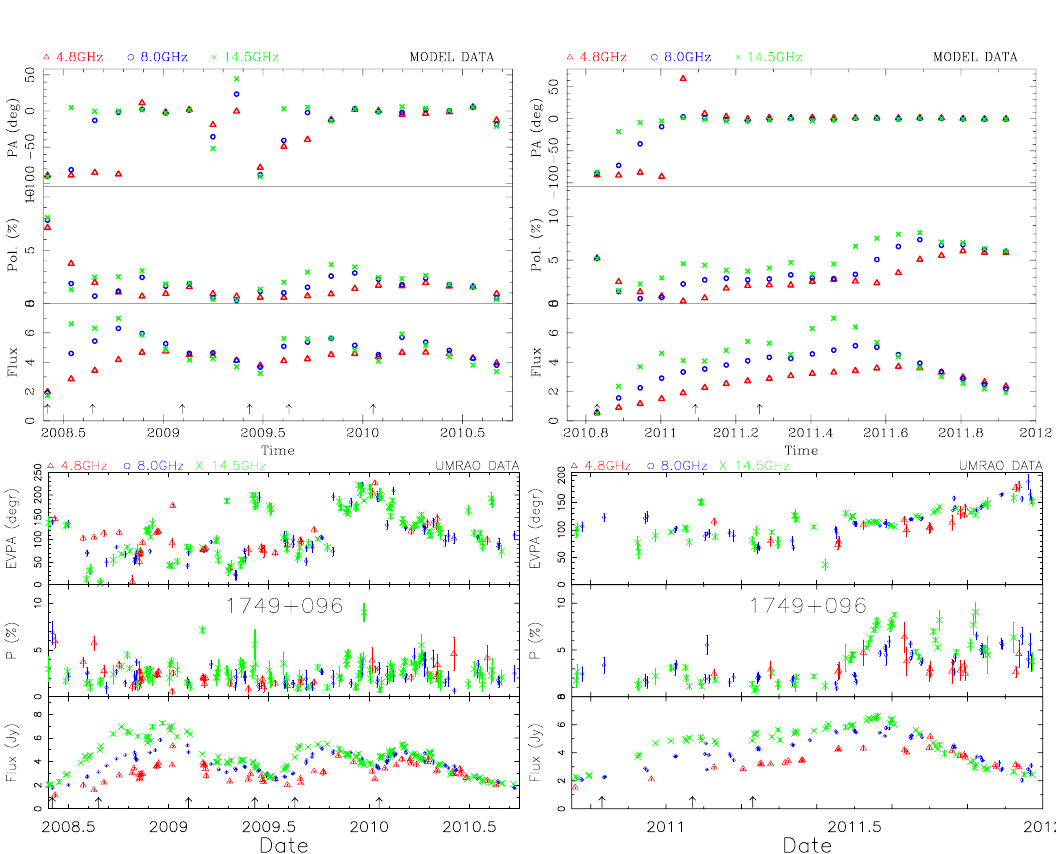
Figure 3. Comparison of the the data (bottom plots) and simulations (top plots) for T2008 ( left ) and T2010 ( right ). Symbols, number of time steps in the simulation, and arrows are as in Figure 2. The shock parameters are given in Appendix A Tables A3 and